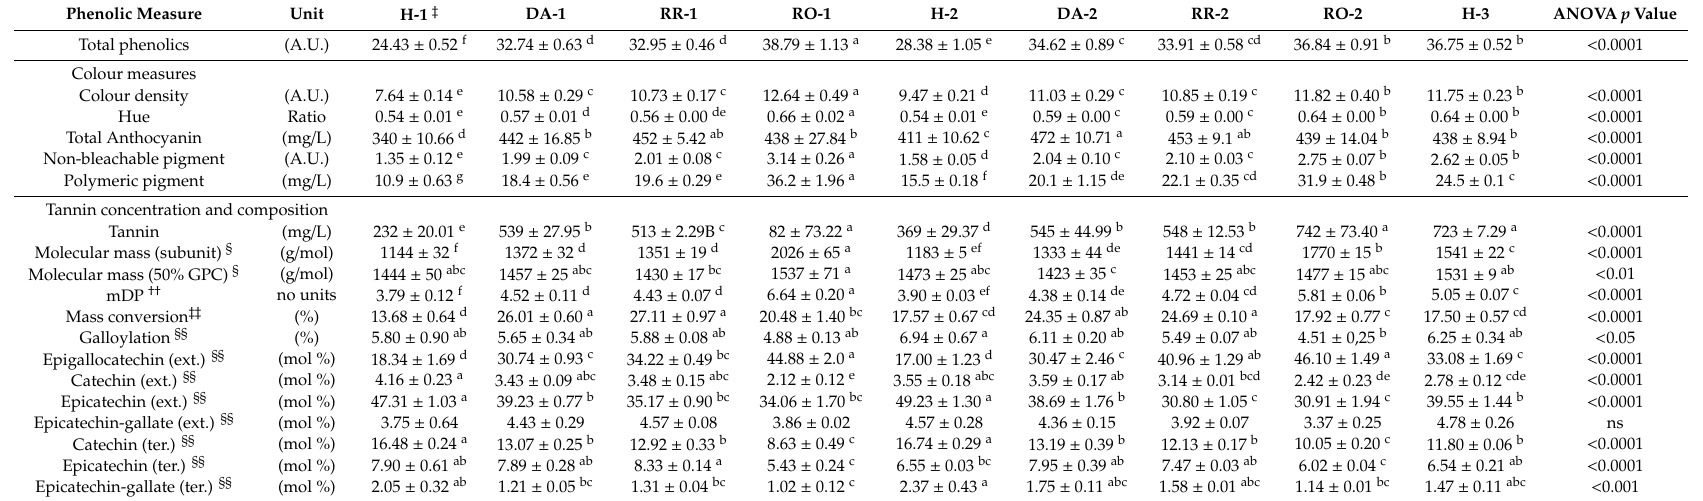
Table 1. Wine phenolic concentration, tannin composition and colour properties in Shiraz wines prepared following harvest time, saigne é and water addition treatments 12 months after fermentation †